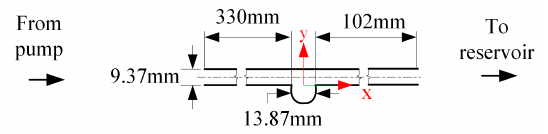
Figure 1. Schematic of the idealized, saccular, aneurysm model.